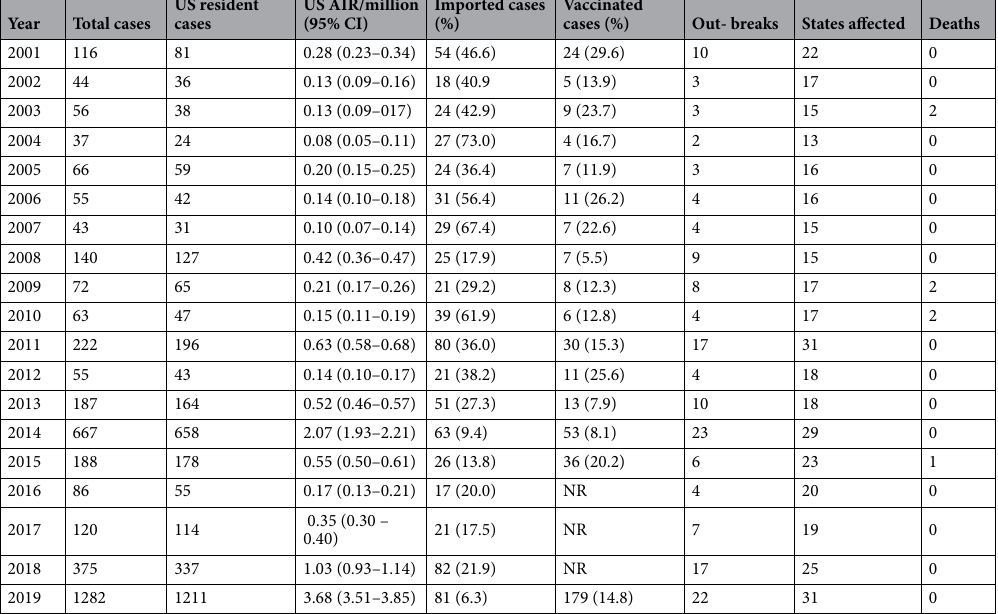
Association between measles annual incidence rates, imported cases, case vaccination status and outbreaks. Table 3 summarises the respective linear regression coefficients, intercepts, p values and R 2 values for the linear associations between the percentage of imported cases, vaccinated cases, outbreaks and the AIR in US residents. There was a moderate negative correlation and linear association between the percentage of imported cases of measles and the AIR in US residents (r = -0.59 and p = 0.008 respectively) (Fig. 3a and Table 3). Regression equation: AIR = 1.503–0.027 * percentage of imported cases. There was a weak negative correlation but no linear association between the percentage of vaccinated cases and the AIR in US residents (r = -0.27 and p = 0.308) (Fig. 3b and Table 3). Regression equation: AIR = 1.191–0.036 * percentage of vaccinated cases. There was a strong negative correlation and linear association between the percentage of imported cases and the number of outbreaks (r = -0.61 and p = 0.006 respectively) (Fig. 3c and Table 3). Regression equation: Outbreaks = 15.579–0.205 * percentage of imported cases. On the other hand, there was a weak positive correlation and no significant linear association between the percentage of unvaccinated cases and the number of outbreaks (r = 0.35 and p = 0.249 respectively) (Fig. 3d and Table 3). Regression equation: Outbreaks = -19.182 + 0.329 * Percentage of unvaccinated cases. There were significant increases in the number of outbreaks ( p = 0.002) and states affected ( p = 0.002) between 2001 and 2019 (Fig. 4a). There was a strong positive correlation and linear association between the number of outbreaks and the number of states affected by measles (r = 0.88 and p < 0.001 respectively) (Fig. 4b and Table 3). Regression equation: States affected = 13.593 + 0.742 * outbreaks. On multiple regression, there was a significant linear association between the AIR in US residents and the number of outbreaks ( p = 0.003) and no more with the percentage of imported cases ( p = 0.436) after adjusting for number of outbreaks and vaccination status. Multiple regression equation: AIR = -0.123–0.008 * percentage of imported cases + 0.009 * percentage of vac- cinated cases + 0.106 * outbreaks. (R 2 = 0.73, p = 0.436, p = 0.692, and p = 0.003 respectively).